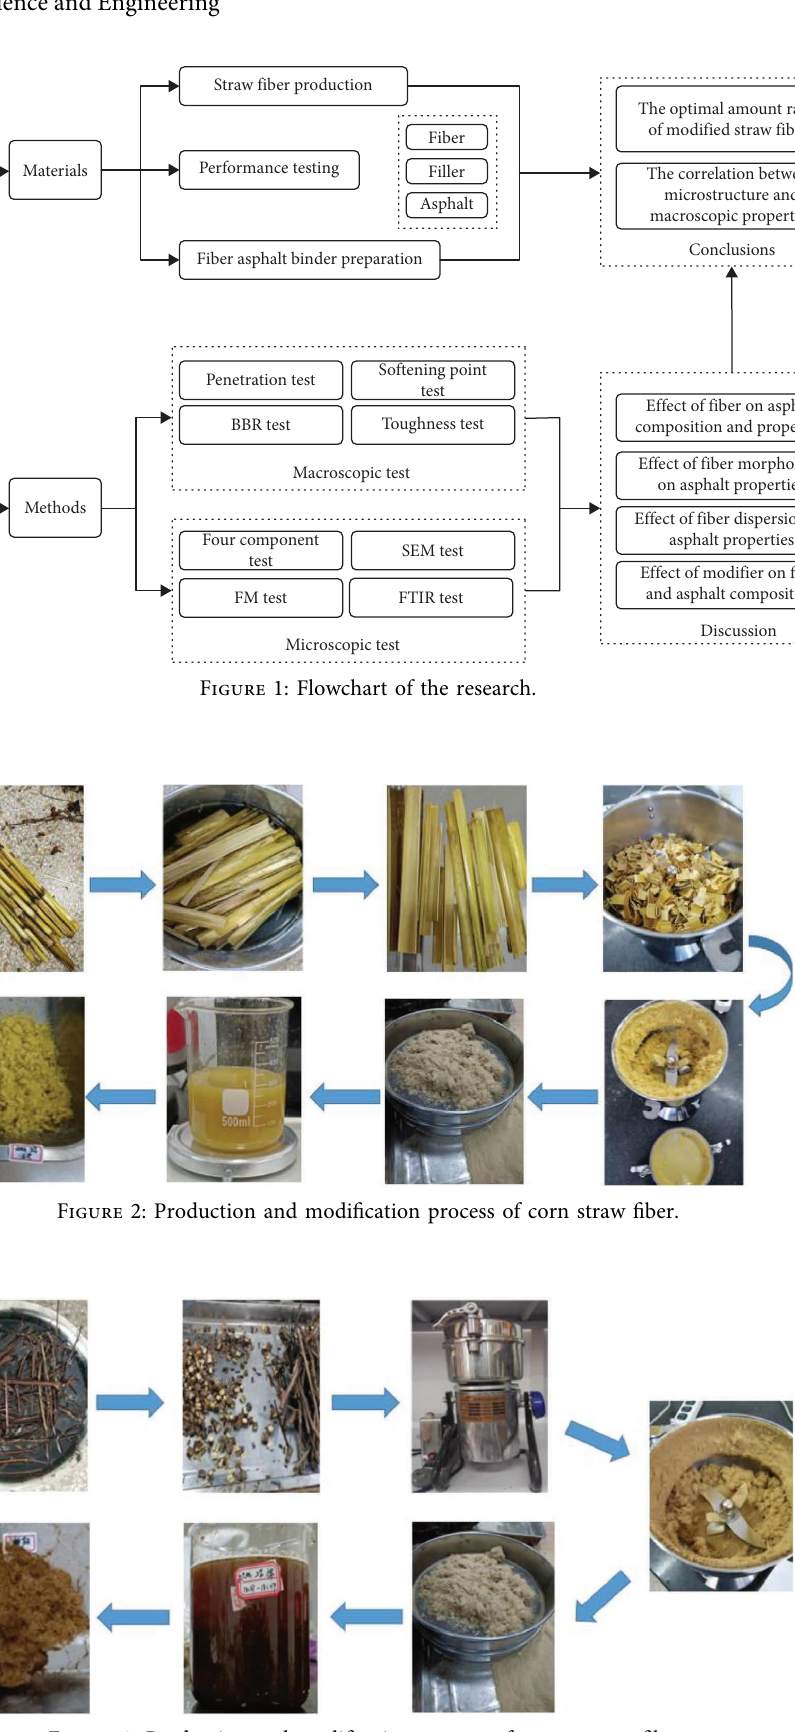
Figure 3: Production and modifcation process of cotton straw fber.